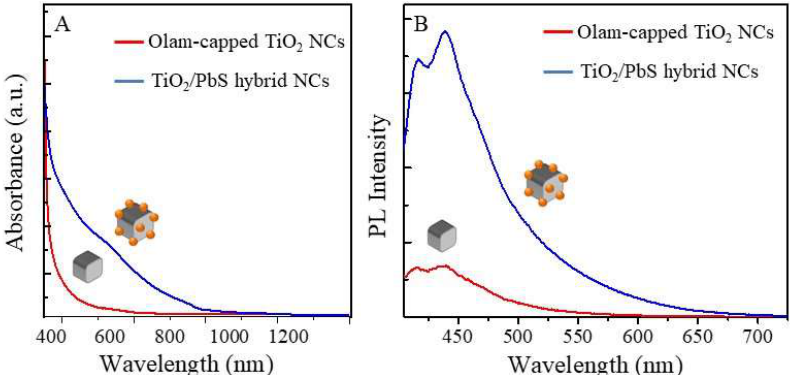
Figure 5. ( A ) UV-Vis-NIR absorbance spectra and ( B ) steady state emission spectra ( λ ex = 375 nm) in the visible spectral range of the Olam-capped TiO 2 seeds (red line) and TiO 2 / PbS hybrid structures (blue line). Each sample has been suitably diluted in order to show the same absorbance value at 375 nm.